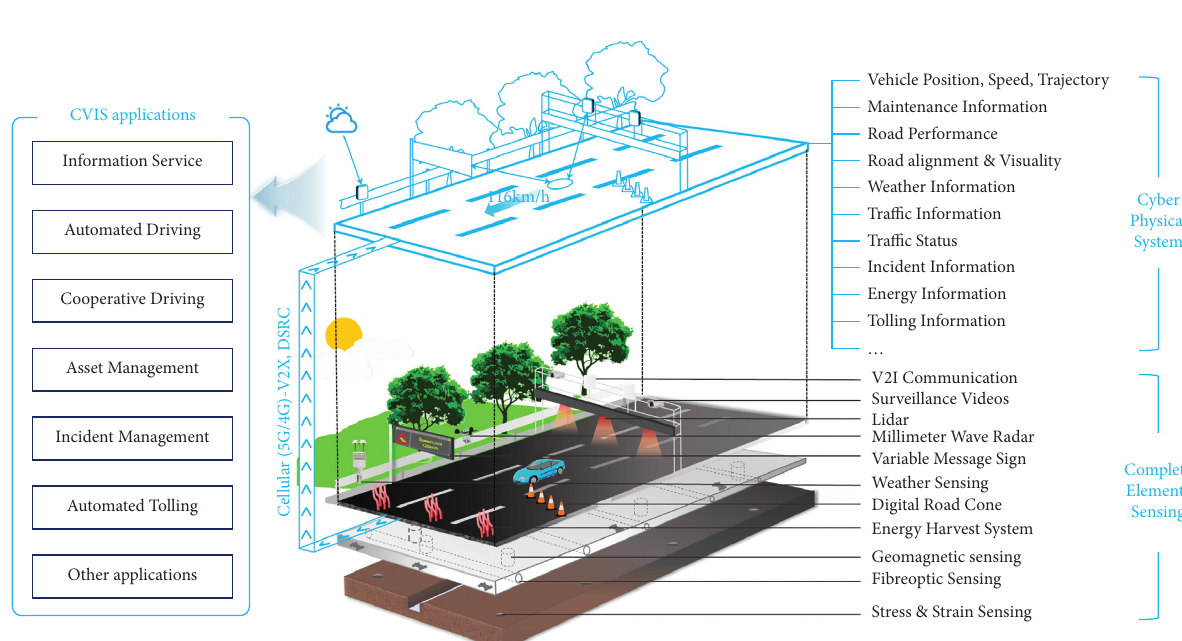
Figure 4: Main components of NGSH.